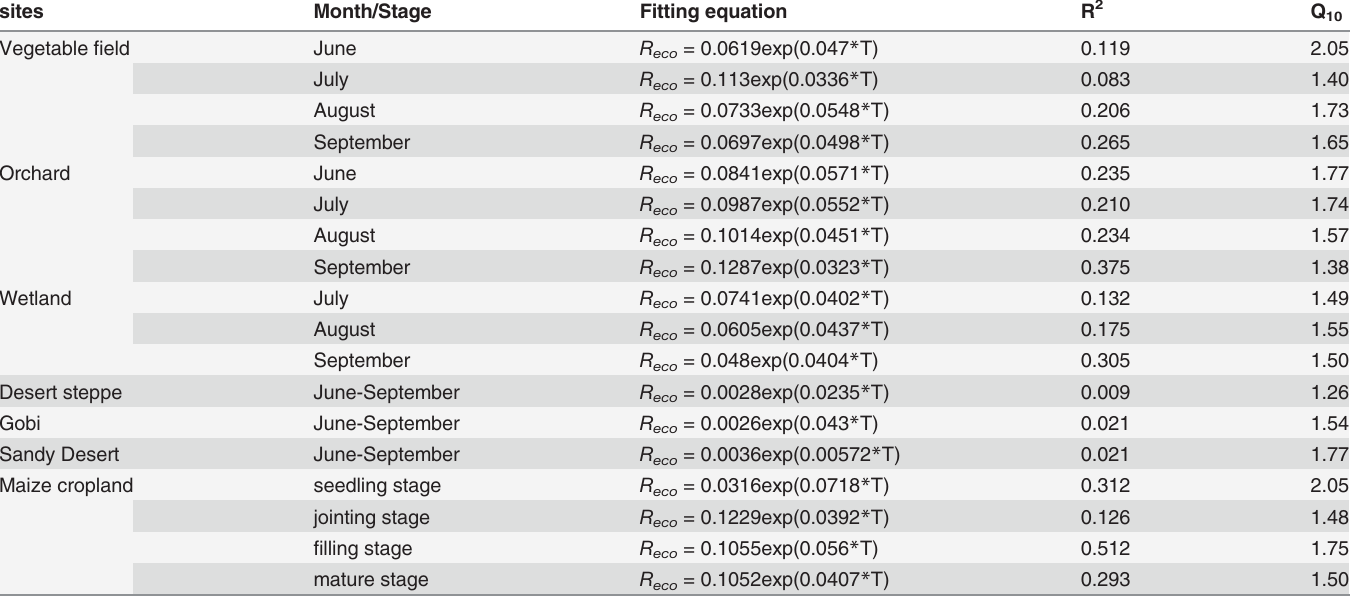
mature stage R eco = 0.1052exp(0.0407 *